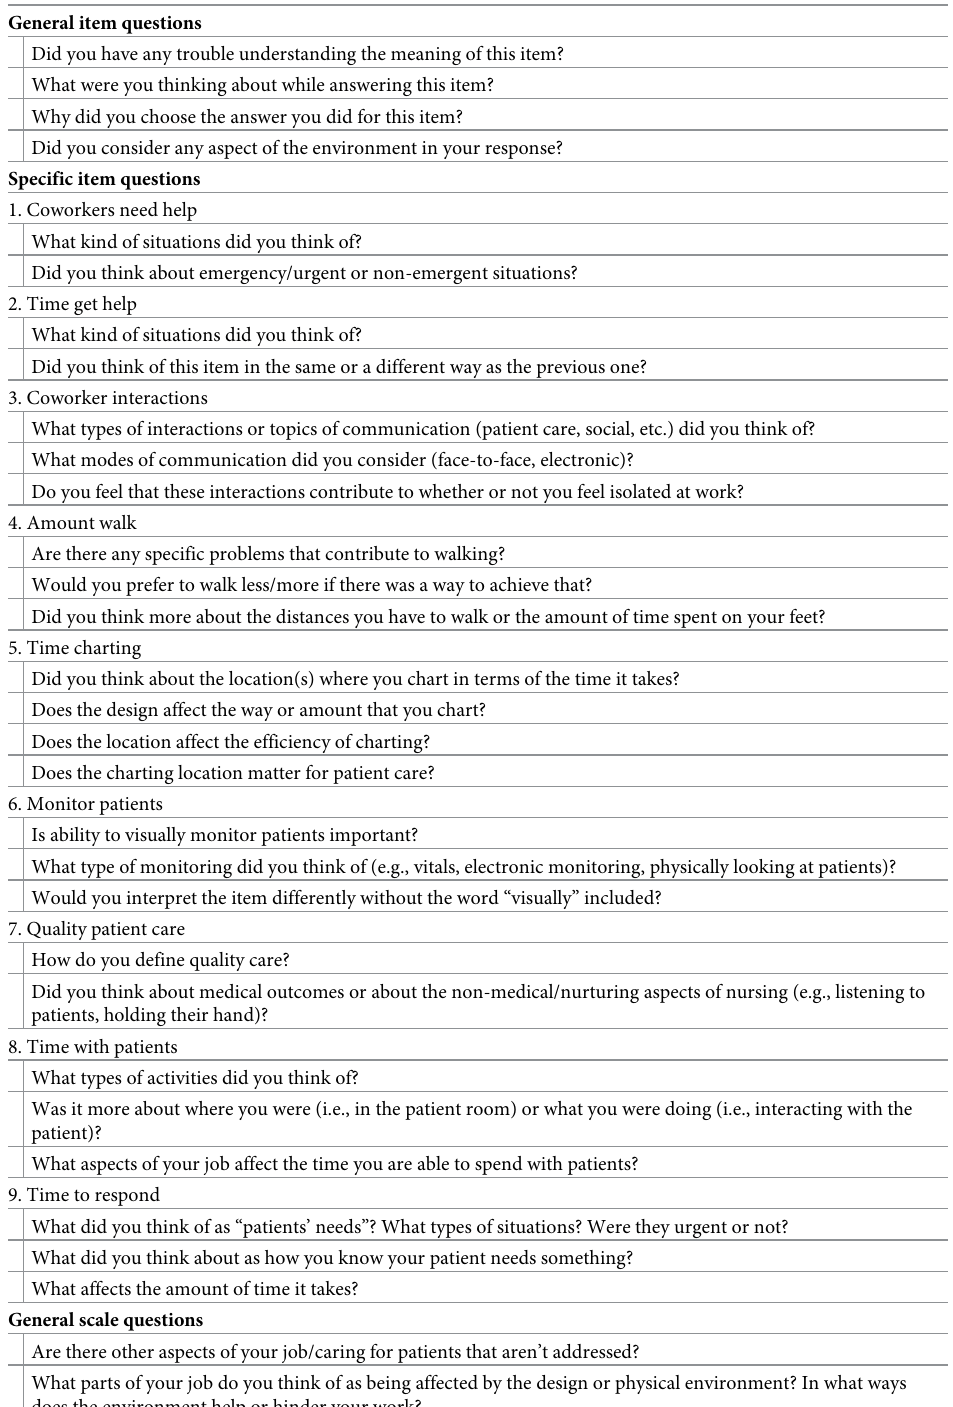
Table 2. Semi-structured questions for cognitive